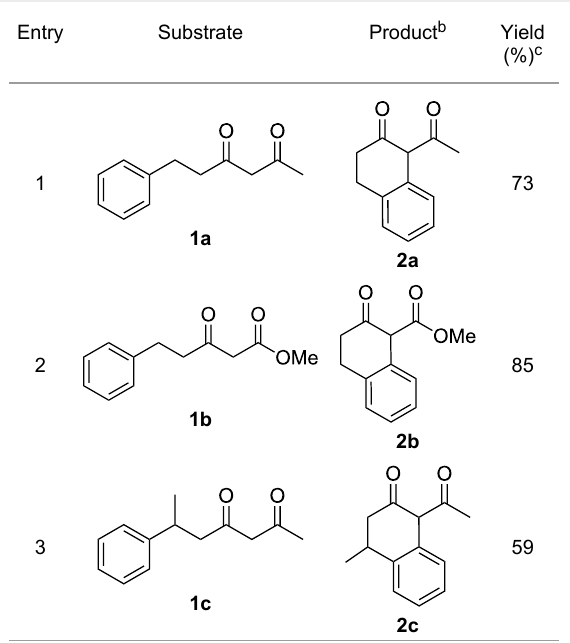
Table 1: CAN-mediated oxidation of δ -aryl- β -dicarbonyl compounds in MeOH a